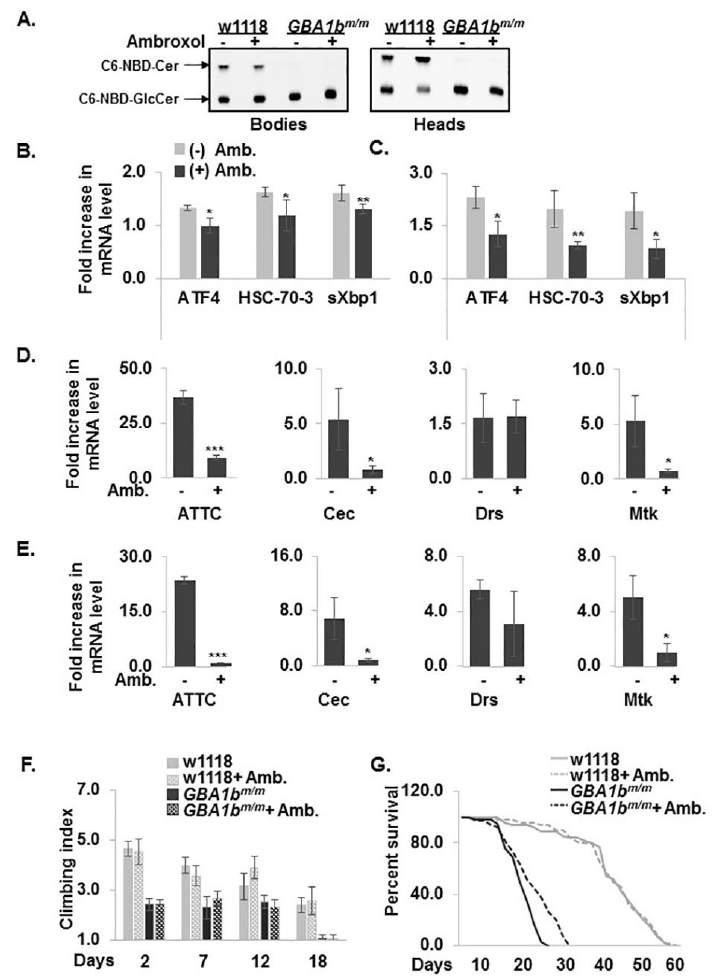
Figure 7. Partial rescue of GBA1b m/m pathologies by ambroxol. ( A ) A TLC plate showing GCase activity as measured in lysates prepared from bodies and heads of control and GBA1b m/m flies, treated or untreated for 12 days with ambroxol. ( B , C ) mRNA levels of UPR markers: ATF4, HSC-70-3 and sXBP1, in bodies ( B ) and heads ( C ) of control (w1118), and GBA1b m/m flies, untreated or treated for 18 days with ambroxol. * p < 0.05, ** p < 0.01, *** p < 0.005. ( D , E ) mRNA levels of inflammation markers: ATTC, Cec, Drs and Mtk, in bodies ( D ) and heads ( E ) of GBA1b m/m flies in comparison to age matched controls (w1118), untreated or treated for 12 days with ambroxol. mRNA levels of the tested genes in untreated control flies were considered 1. ( F ) Thirty flies from each line were untreated or treated for 12 days with ambroxol and analyzed for locomotion behavior at Days 2, 7, 12 and 18 post eclosion. ( G ) A curve showing the overall survival of w1118 and GBA1b m / m flies untreated or treated for 12 days with ambroxol. The numbers represent three independent experiments. * p < 0.05, ** p < 0.01, *** p < 0.005.